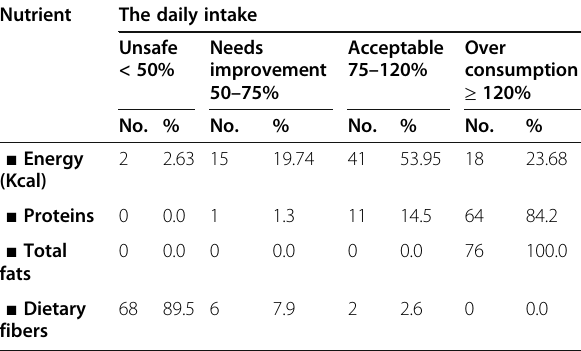
Table 3 The daily caloric and macronutrients ’ intake from diet among the studied multiple sclerosis patients at Kasr Al-Ainy Hospital Nutrient